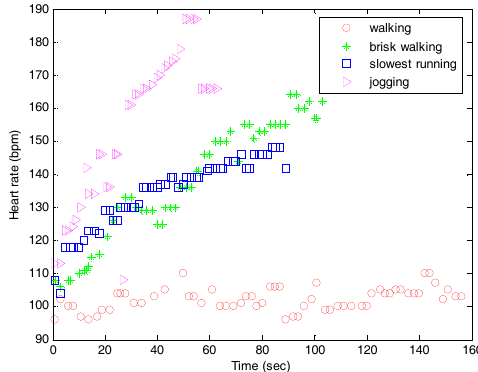
Figure 11. Experimental photo of field test.